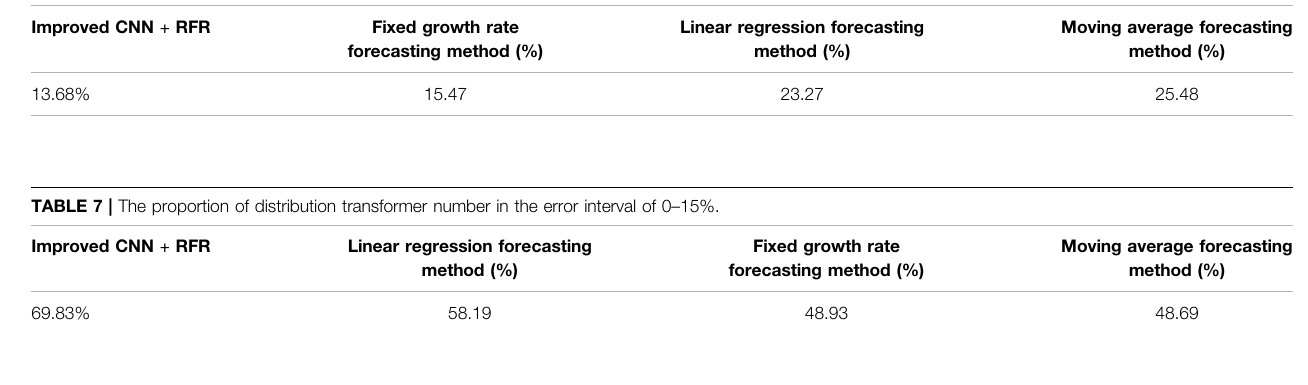
TABLE 6 | The Mean Absolute Percentage Error of different methods.